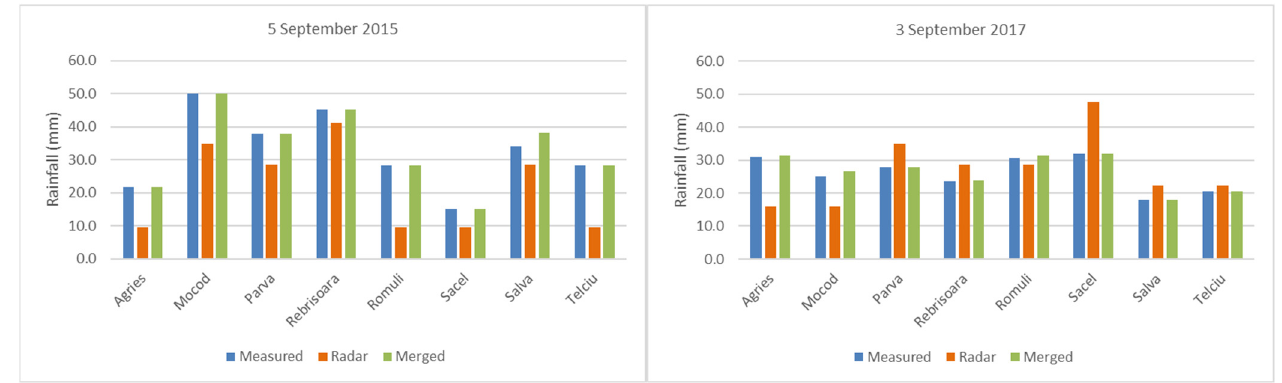
Figure 7. Convective cells comparative rainfall amounts.